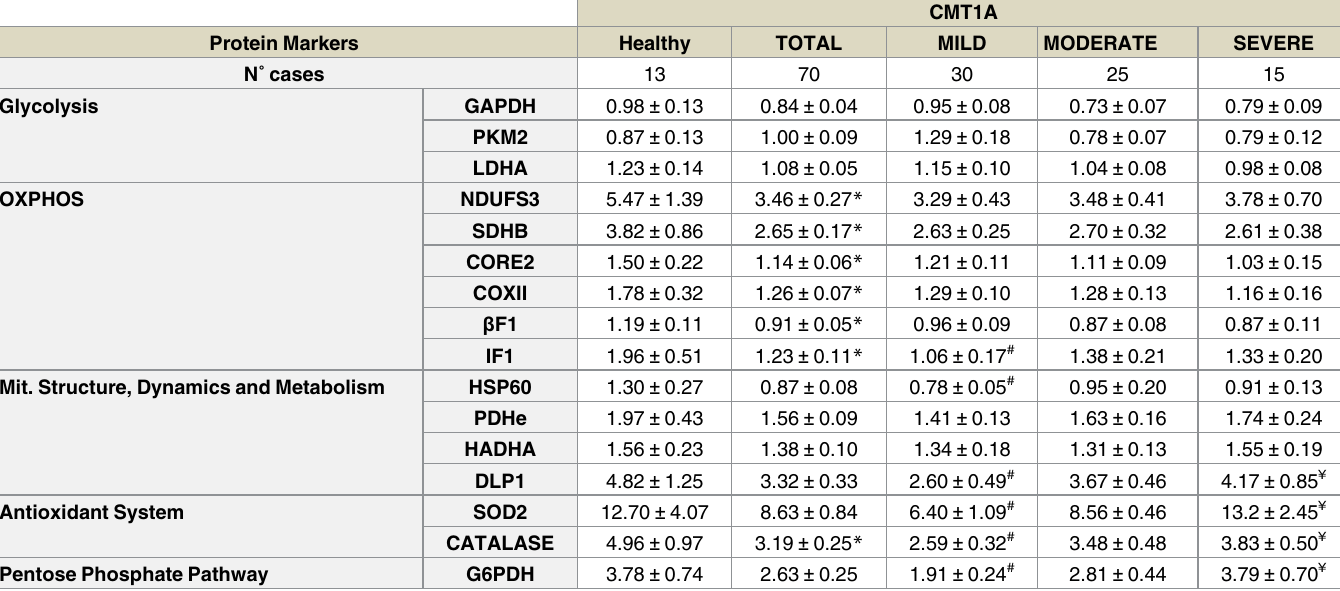
Table 1. Protein expression in skin biopsies of CMT1A patients.